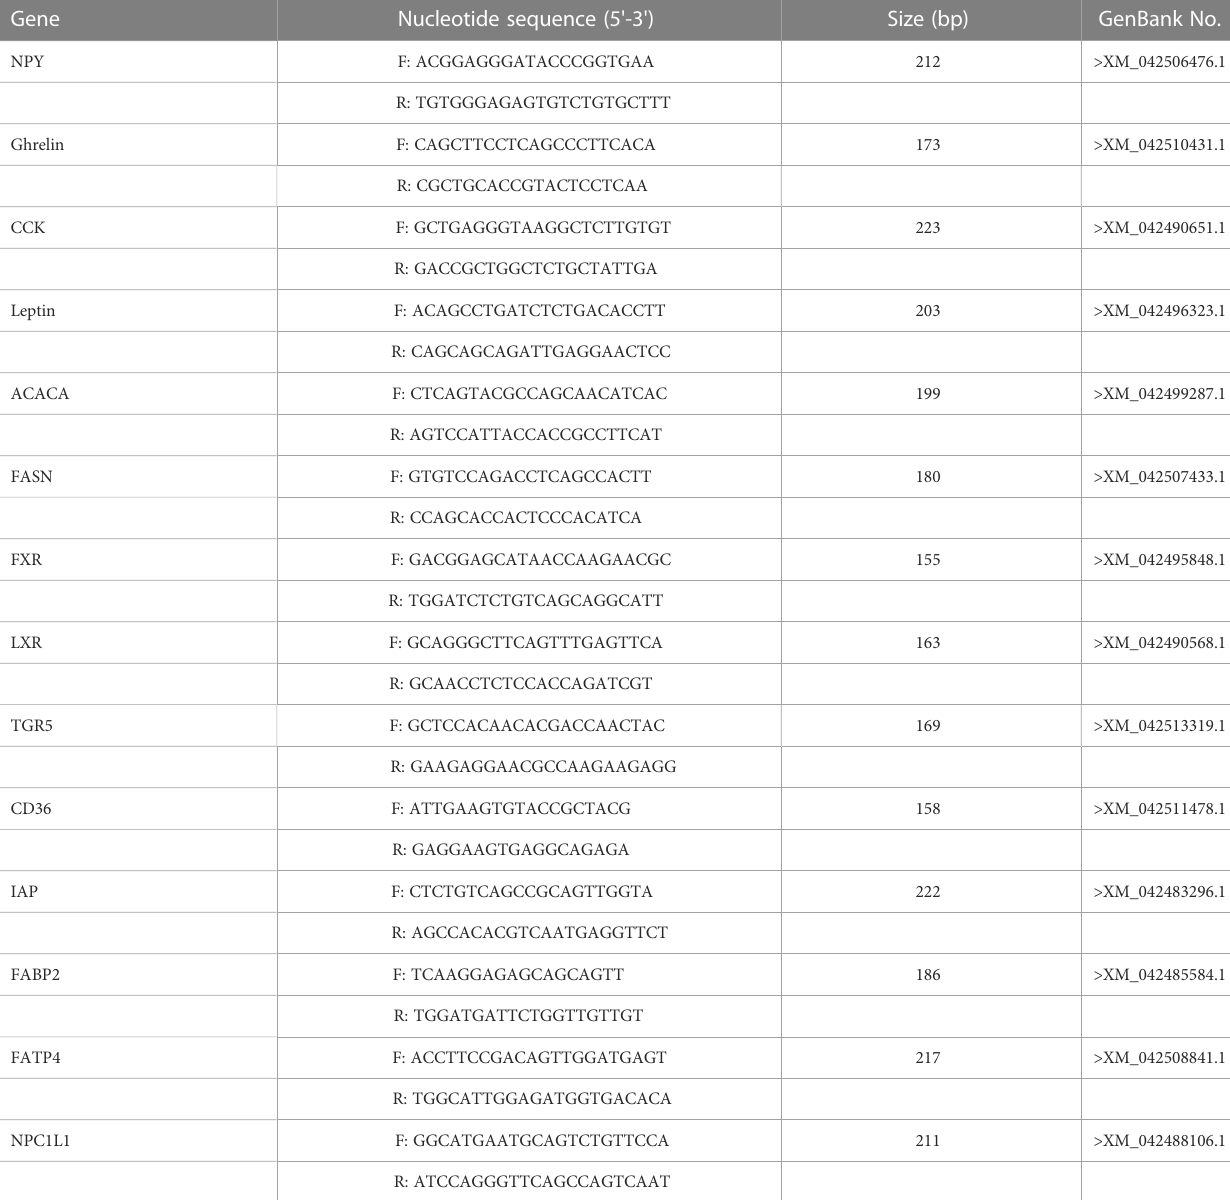
TABLE 2 Primer sequences used for real-time